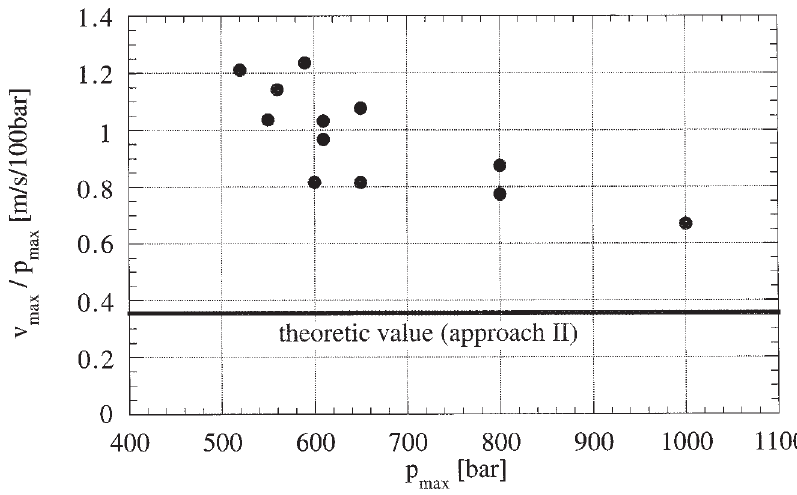
Fig. 14. Comparison between measured and theoretical values of the vibration velocities. The vibration velocities obtained in different experi- ments at different initial acetylene pressures were scaled by dividing through the respective detonation pressure p max , which was expressed in multiples of 100 bar.